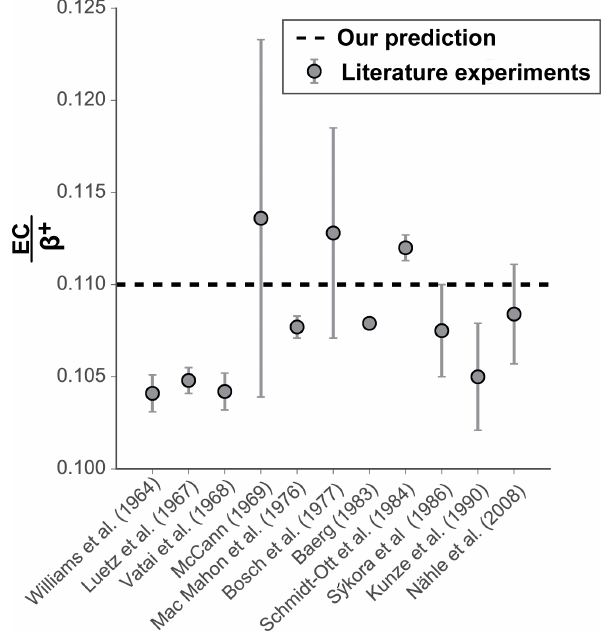
Figure 4. Comparison of experimentally measured (EC /β + )* ra- tios of 22 Na (grey circles) adapted from Kunze et al. (1990) with our calculated value (dashed black line). Note the concordance of the theoretical and experimental determinations. The uncertainty in the Baerg (1983) determination is smaller than the